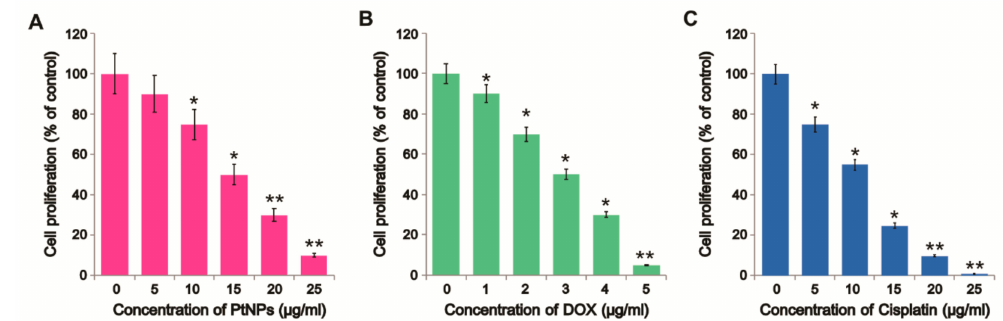
Figure 3. Dose-dependent e ff ect of PtNPs, DOX, and CIS on U2OS cell proliferation. U2OS cell proliferation was determined after exposure to di ff erent concentrations of ( A ) PtNPs (5–25 µ g / mL) or ( B ) DOX (1–5 µ g / mL) or ( C ) CIS (5–25 µ g / mL) for 24 h. Results are expressed as the mean ± standard deviation of three independent experiments. Di ff erences between the treated and control groups were measured using Student’s t -test and statistically significant di ff erences are indicated by * ( p < 0.05). The results are presented as mean ± standard deviation of three experiments. * p < 0.05 was considered significant; ** p < 0.01 was considered highly significant and *** p < 0.001 was considered very highly